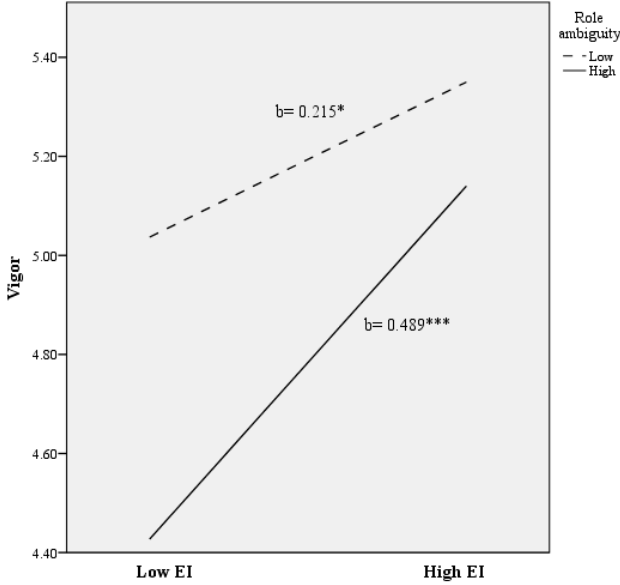
Figure 1. The relationship of emotional intelligence and role ambiguity for predicting vigor scores.